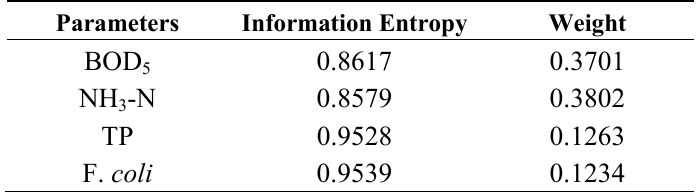
Table 4. Weights of parameters calculated by entropy method.